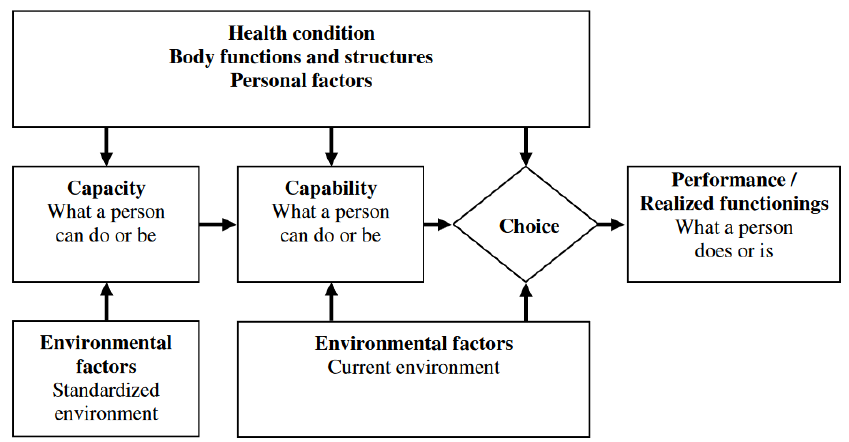
Figure 1. Relationships between constructs of the WHO ICF and the capability approach (reprinted with permission from the author).